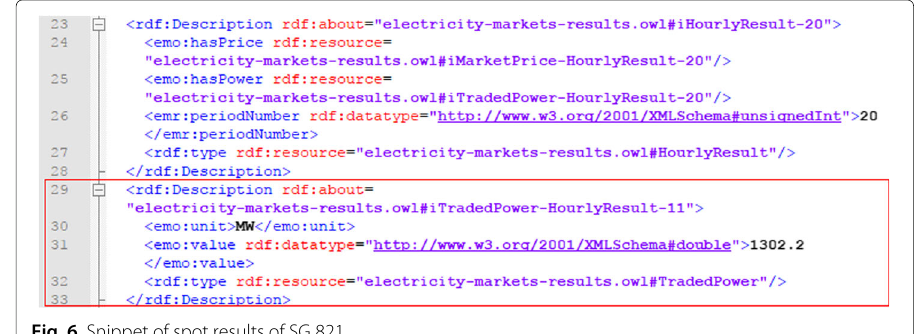
Fig. 6 Snippet of spot results of SG